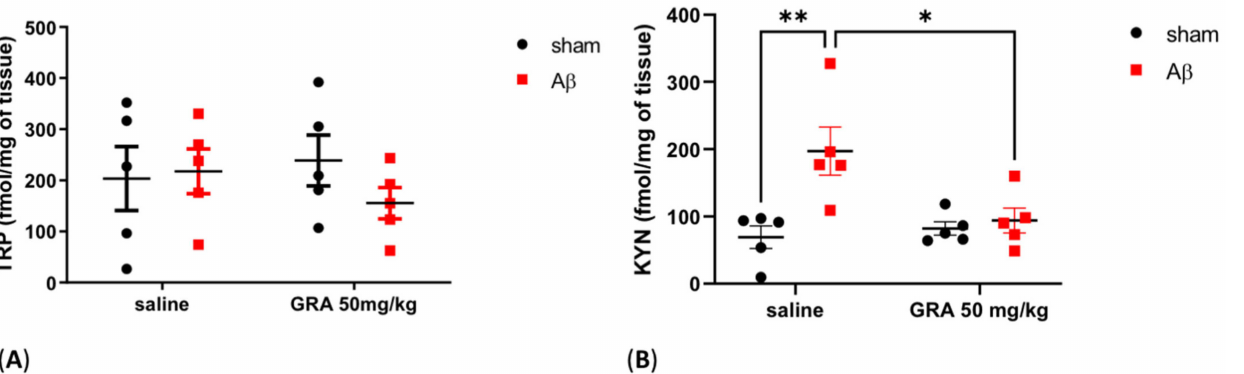
Figure 5. Effect of GRA administration on cortical TRP and KYN quantifications in sA β -1-42-treated rats. Effect of GRA (50 mg/kg) administration on cortical TRP (( A ), n = 5 per group) and KYN (( B ), n = 5 per group) in rats 7 days after i.c.v. injection of vehicle (sham, 5 µ L, black dots) or A β (A β , 4 µ M, red dots). ** p < 0.01 saline sA β 1-42 vs. saline sham; * p < 0.05 GRA sA β 1-42 vs. saline sA β 1-42. Two-way ANOVA followed by Bonferroni’s post hoc